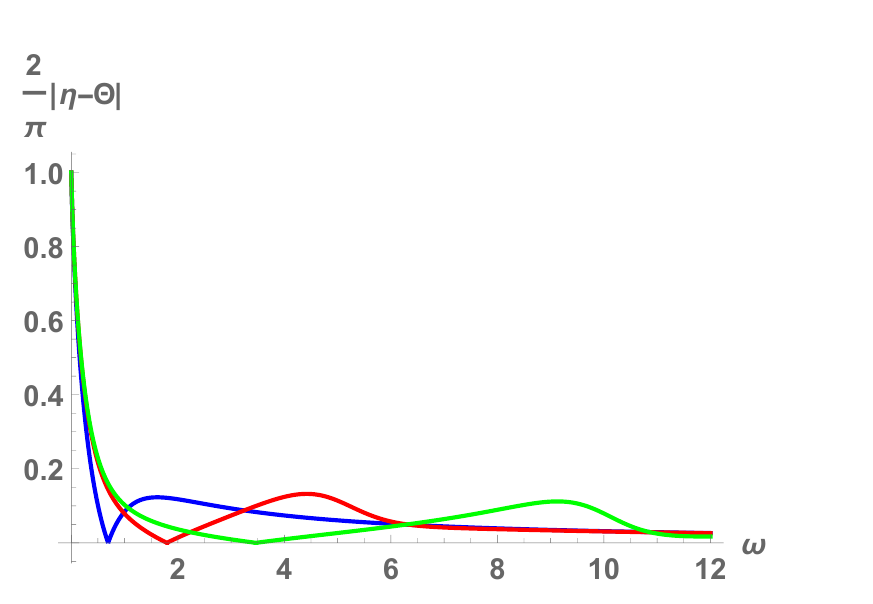
Figure 9. A plot of (2 /π ) | ( η − Θ) mod π | as a function of ω . We take R = r + = 1 , and λ = 10 − 20 ( L λ ≈ 94 . 88 ). The blue, red, and green lines respectively correspond to k = 0 , 5 , 10 . The mismatch starts out maximally at π/ 2 (see (4.35)) but asymptotes (quickly) to zero (see